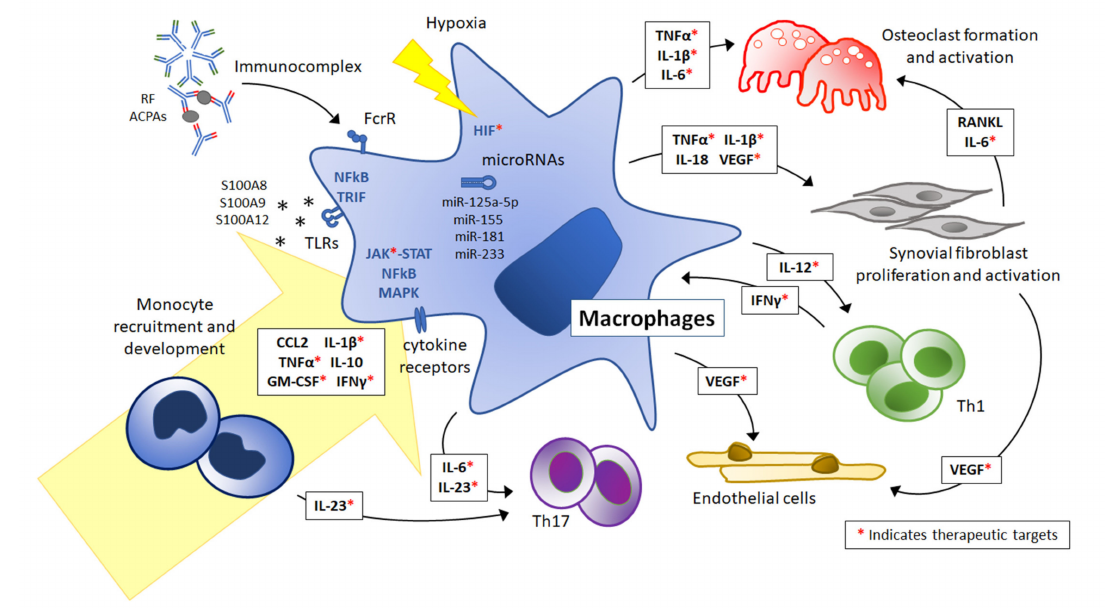
Figure 1. Therapeutic targets related to monocyte and macrophage activation in juvenile idiopathic arthritis. Monocytes (Mos) were recruited to the joints by CCL2 and differentiated into tissue macrophages (M ϕ s) under inflammatory conditions. IL-1 β , TNF α , IFN γ , GM-CSF, and IL-10 are especially important for the differentiation process. Upon stimulation with cytokines, immunocomplexes, TLR ligands, the hypoxic microenvironment, and microRNAs, the mixed polarization of M ϕ s toward an inflammatory phenotype was mediated via the JAK-STAT, MAPK, NF κ B, TRIF, and HIF signaling pathways. Proinflammatory cytokines, including IL-1 β , IL-6, IL-12, IL-18, IL-23, and TNF α were secreted to stimulate activation of osteoclasts and synovial fibroblasts and to promote T lymphocyte polarization. VEGF drives synovial angiogenesis, contributing to JIA pathogenesis. Available therapeutic targets are marked with red asterisks *. Abbreviations: RF, rheumatoid factor; ACPAs, anti-citrullinated protein antibodies; CCL2, monocyte chemoattractant protein 1; TLRs, Toll-like receptors; Fc γ R, Fc gamma receptor; JAK, Janus kinase; STAT, signal transducer and activator of transcription; MAPKs, mitogen-activated protein kinases; TRIF, TIR-domain-containing adapter-inducing interferon; NFkB, nuclear factor kappa-light-chain-enhancer of activated B cells; HIF, hypoxia-inducible factor; Th1, type 1 T helper cells; Th17, type 17 T helper cells; RANKL, receptor activator of nuclear factor kappa beta